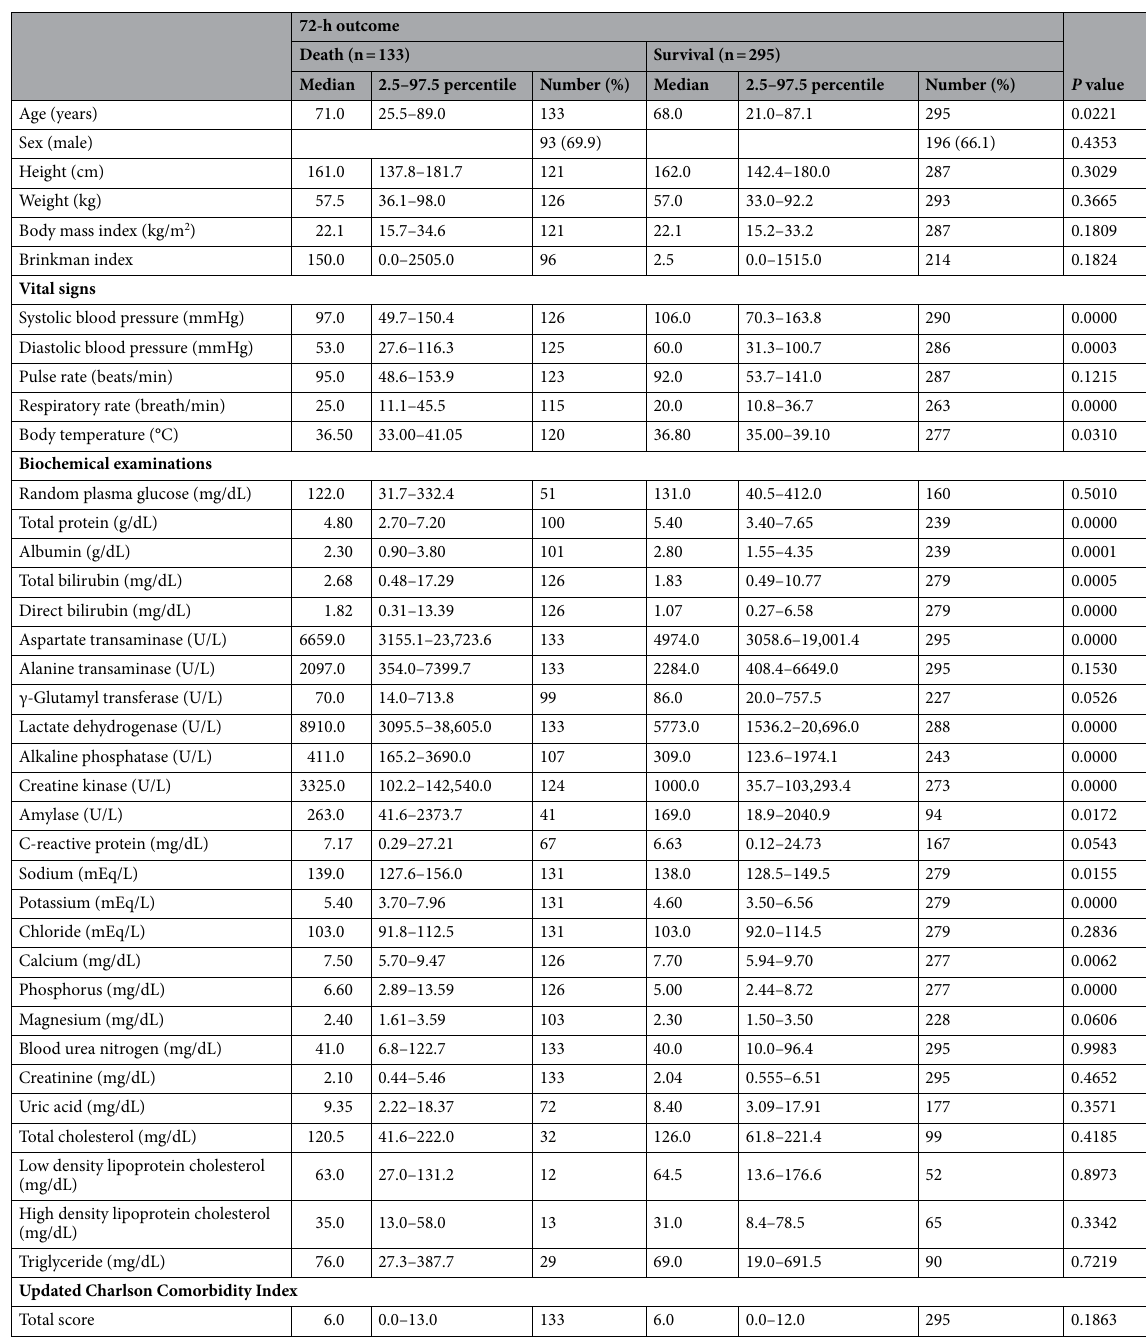
Table 1. Characteristics, demographics, vital signs, laboratory test values, and updated Charlson Comorbidity Index score of patients included in this study. P- values were calculated using the Mann–Whitney U